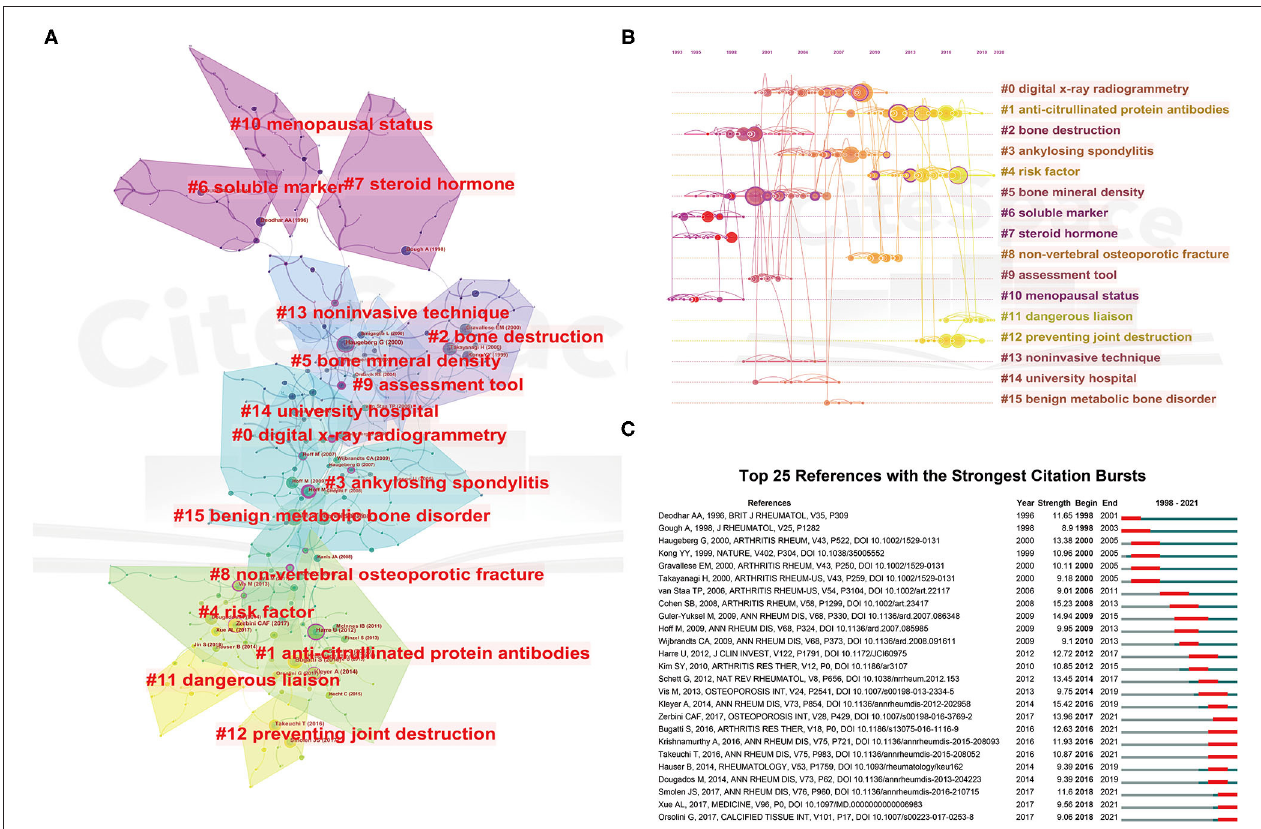
FIGURE 6 | The cluster view map (A) and timeline view map (B) of reference co-citation analysis were generated by CiteSpace. (C) Visualization map of top 25 references with the strongest citation bursts involved in